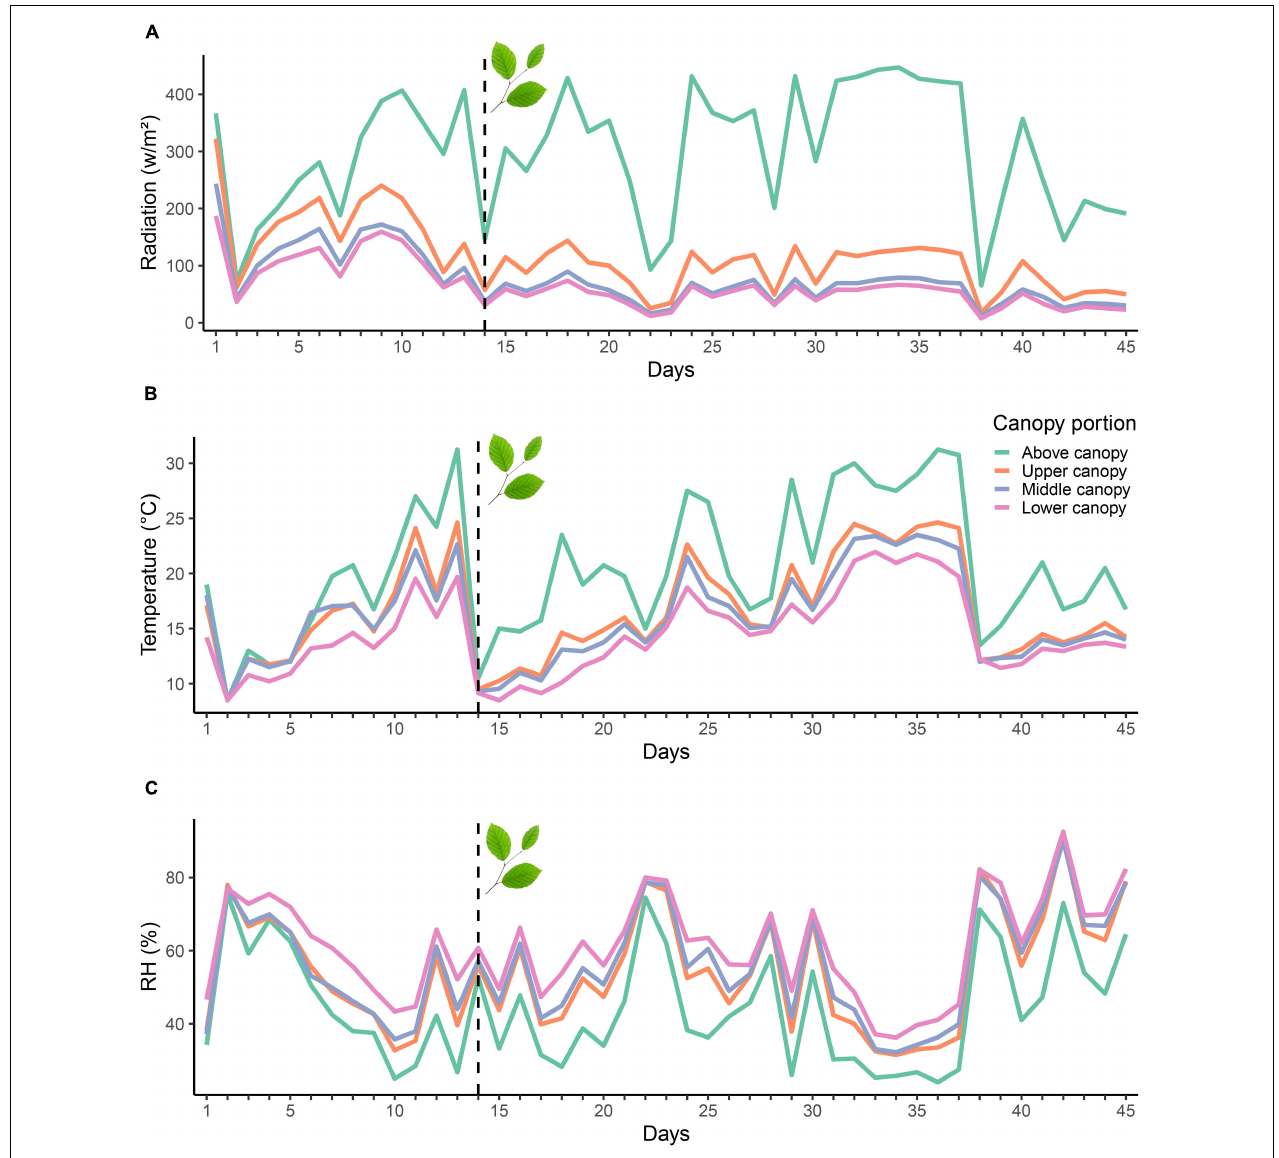
FIGURE 4 | Mean radiation (A) , temperature (B) and RH (C) variability measured above and within the tree at different canopy positions (lower, middle, and upper) during the study period (May-June). The dashed line represents the transition from the leaf-out to the foliaged